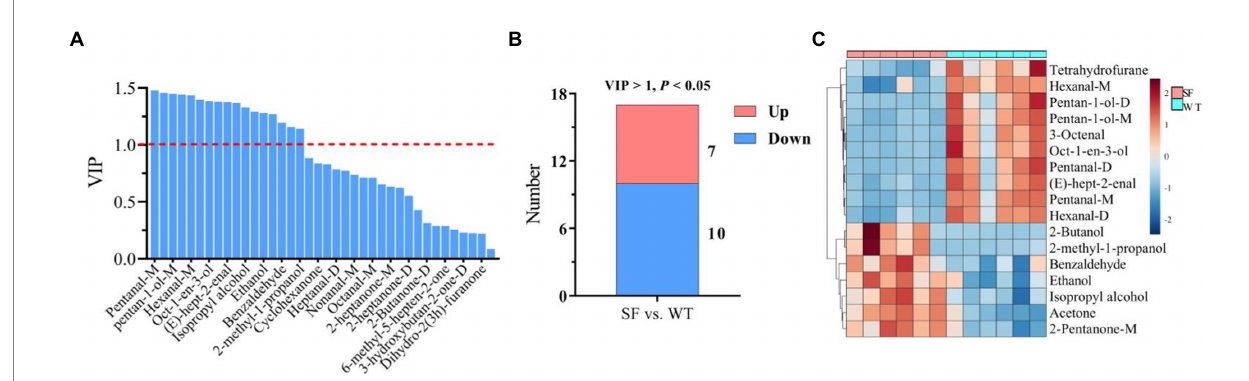
FIGURE 4 Differential volatile components between donkey meats from two strains. Variable importance in projection (VIP) of volatile components (A) . Number of significantly different volatile components (B) . Heatmap analysis of differential volatile components (C) . SF, Sanfen; WT,